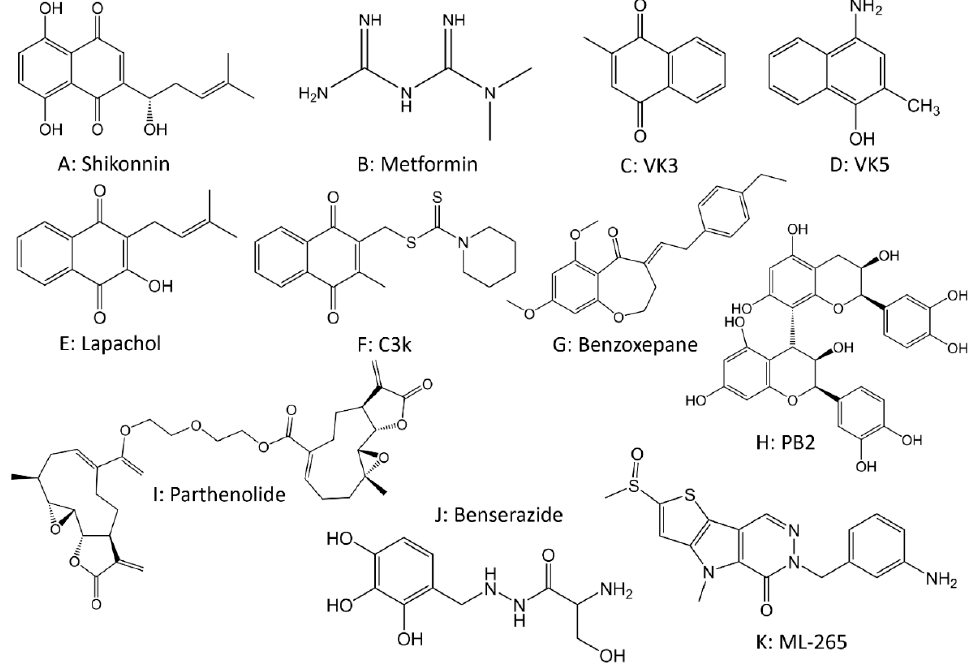
Figure 6. The chemical structures of drugs targeting pyruvate kinase.